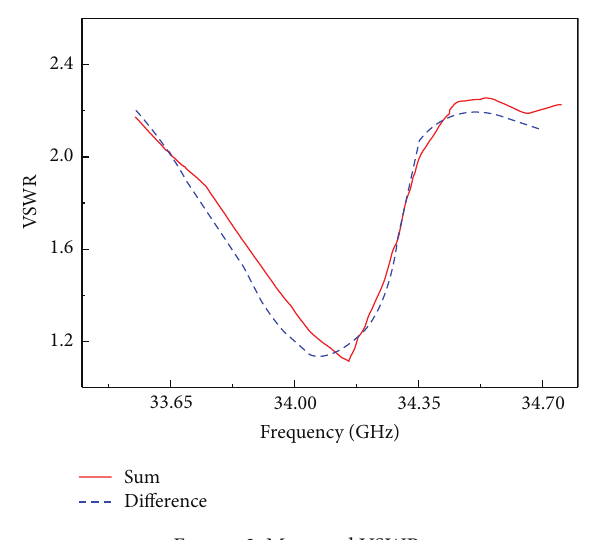
Figure 2: Measured VSWR.